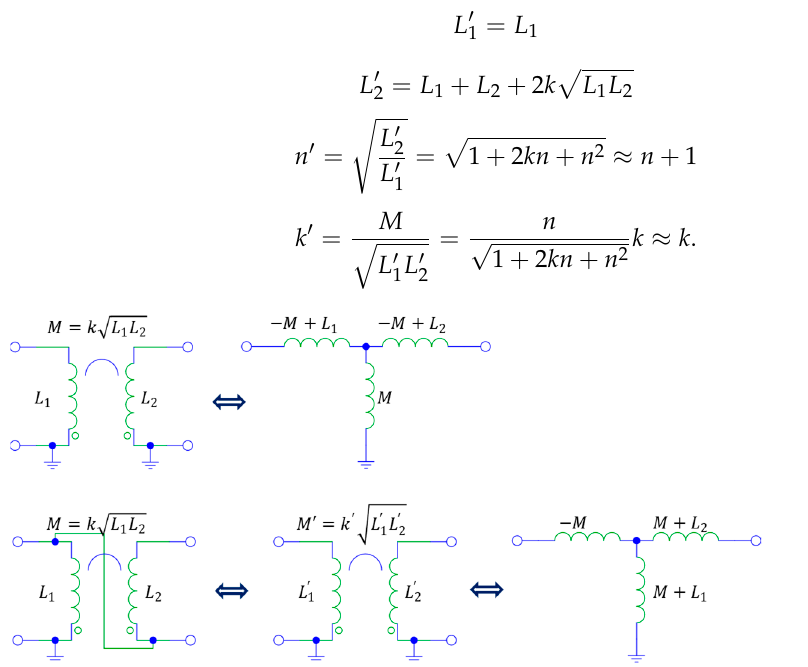
Figure 8. Two connection ways of the transformer circuit and their equivalent parameters.